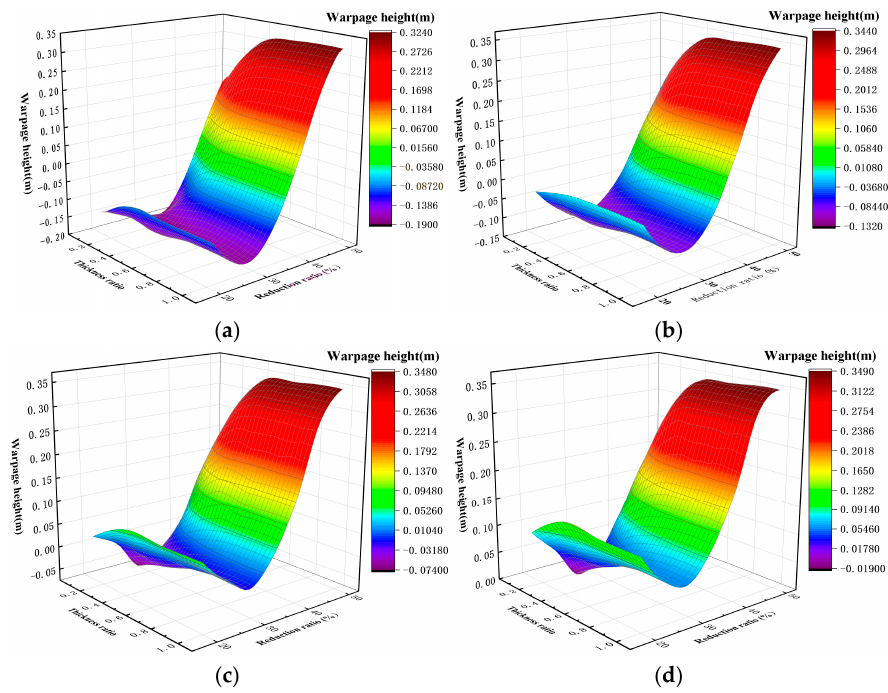
Figure 12. Simulation results of warpage height with different reduction ratios and thickness ratios. ( a ) V upper roll /V lower roll = 1.06, ( b ) V upper roll /V lower roll = 1.04, ( c ) V upper roll /V lower roll = 1.02, ( d ) V upper roll /V lower roll = 1.0.